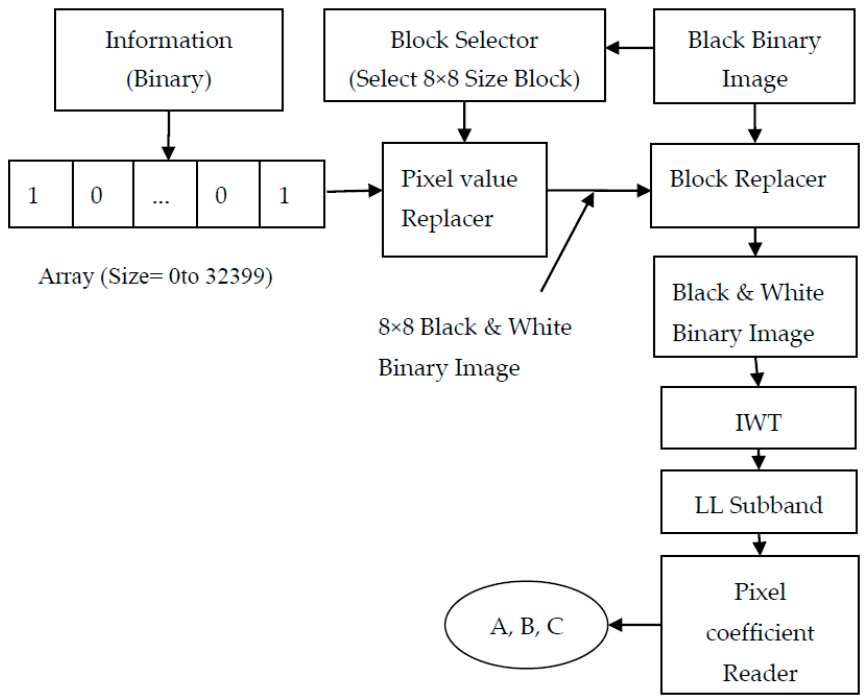
Figure 3. Black & White Binary Image Creation for Red, Green& Blue plane.